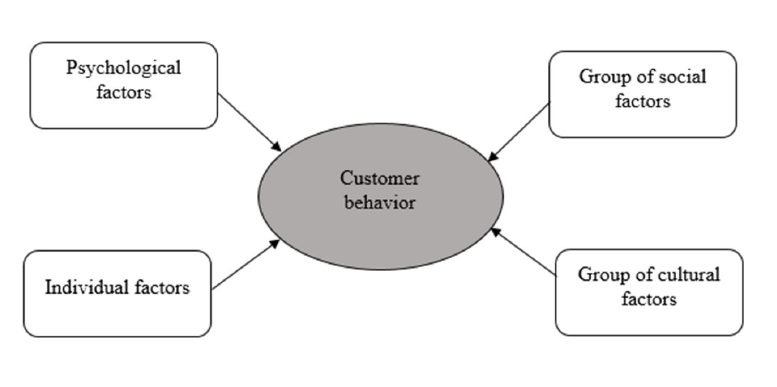
Fig. 1. Proposed model of this